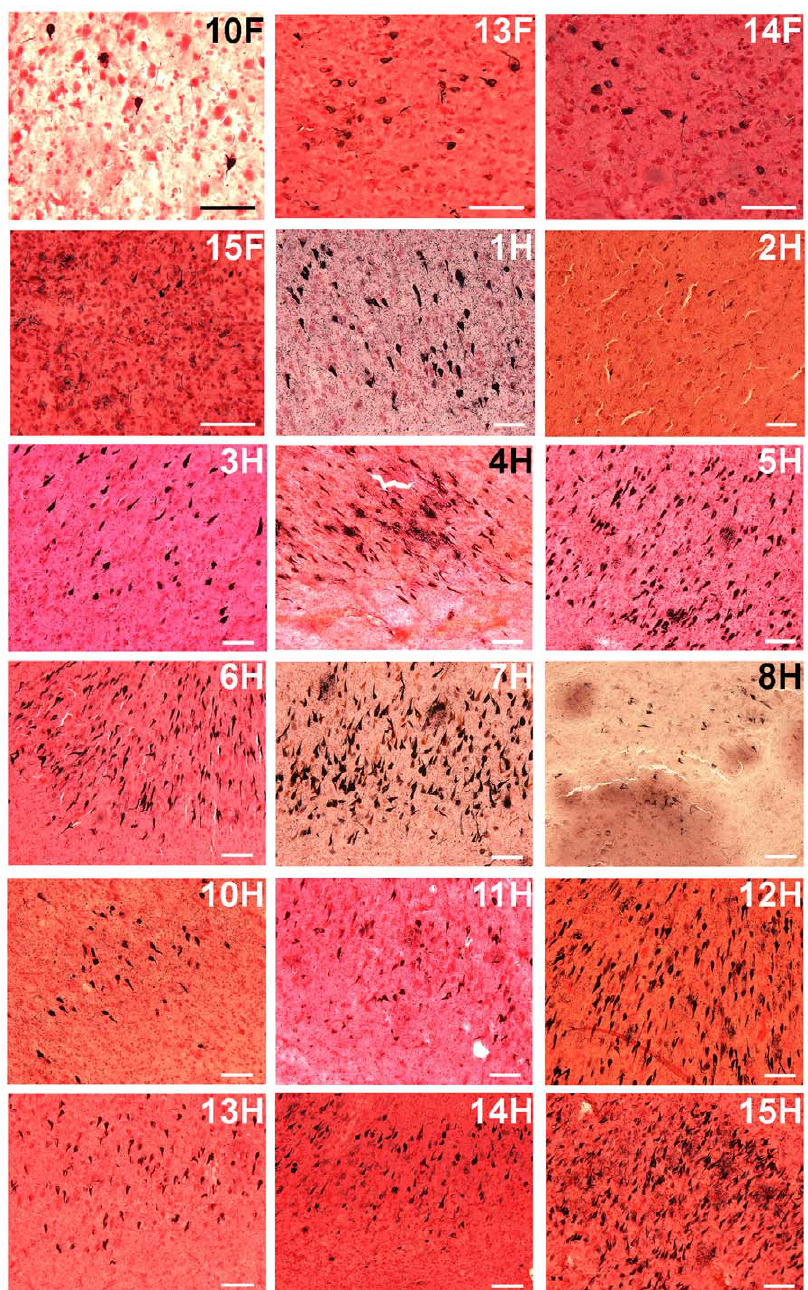
Figure 2. Neurofibrillary tangles stained by the Gallyas technique. The histological fields are representative of the neurofibrillary tangle abundance shown in 40 m m coronal sections of the frontal lobe and hippocampus. The numbers on the top right corners correspond to the case identification numbers given in Table 1 and the letters F and H represent frontal cortex and hippocampus, respectively. Scale bars =100 m m.